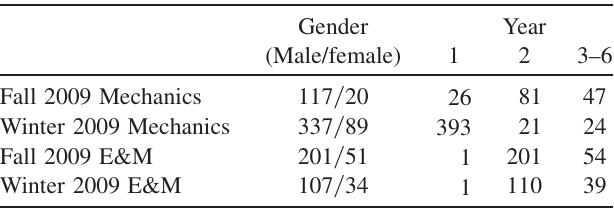
TABLE II. Demographic data for students taking the tasks. Mechanics is typically taken in the winter quarter of students’ first year. Students typically take E&M in the fall of their second year. Women make up 14%–24% of the